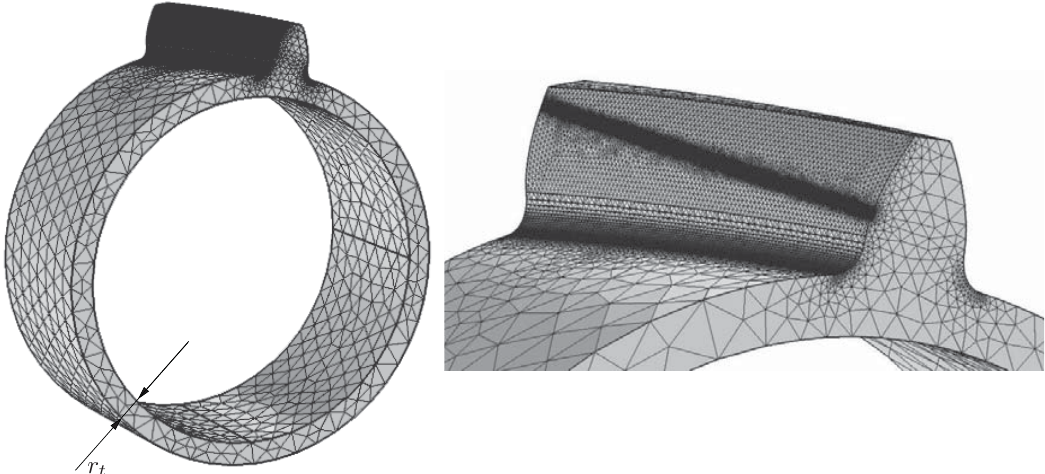
Figure 13: FE mesh for the rim size influence on the stiffness, left the full mesh; right a zoom of the tooth. body simulation.